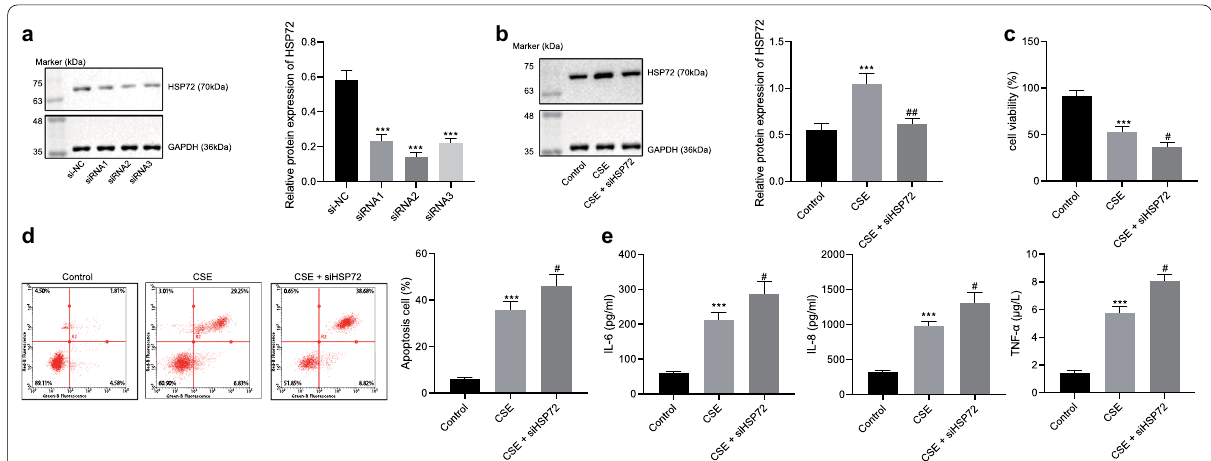
Fig. 2 Knockdown of HSP72 exacerbates CS-induced injury on MLE-12 cells. a Relative protein expression of HSP72 following treatment of HSP72 siRNA normalized to GAPDH was evaluated by immunoblotting; * p < 0.05, ** p < 0.01, *** p < 0.001 compared to cells transfected with si-NC. b MLE-12 cells was transfected with si-HSP72 and stimulated with 5% CSE, and the expression of HSP72 normalized to GAPDH was detected by immunoblotting. CSE was exposed to control and HSP72 knocked down cells. c Cell viability was tested with CCK-8 assay. d Cell apoptosis was tested with flow cytometry. e The release of IL-6, IL-8, and TNF-α was detected by ELISA, * p < 0.05, ** p < 0.01, *** p < 0.001 compared to untreated cells, # p < 0.05, ## p < 0.01, ### p < 0.001 compared to cells treated with CSE. All experiments were repeated for three times independently and the data were represented as mean standard deviation. One-way ANOVA followed by Tukey’s test was used for multiple group ±